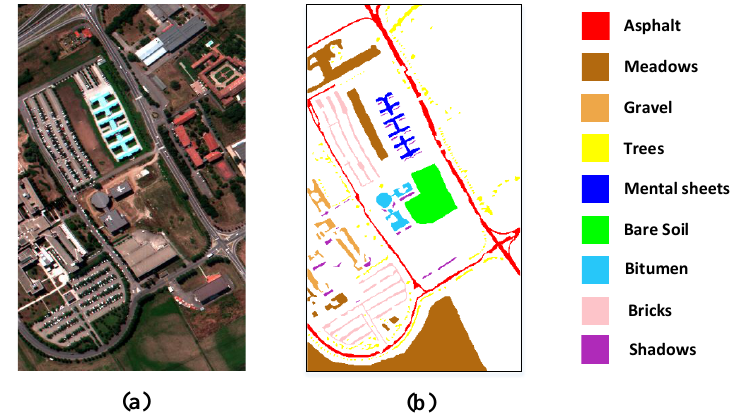
Figure 9. Pavia University data: ( a ) False-color map. ( b ) Available